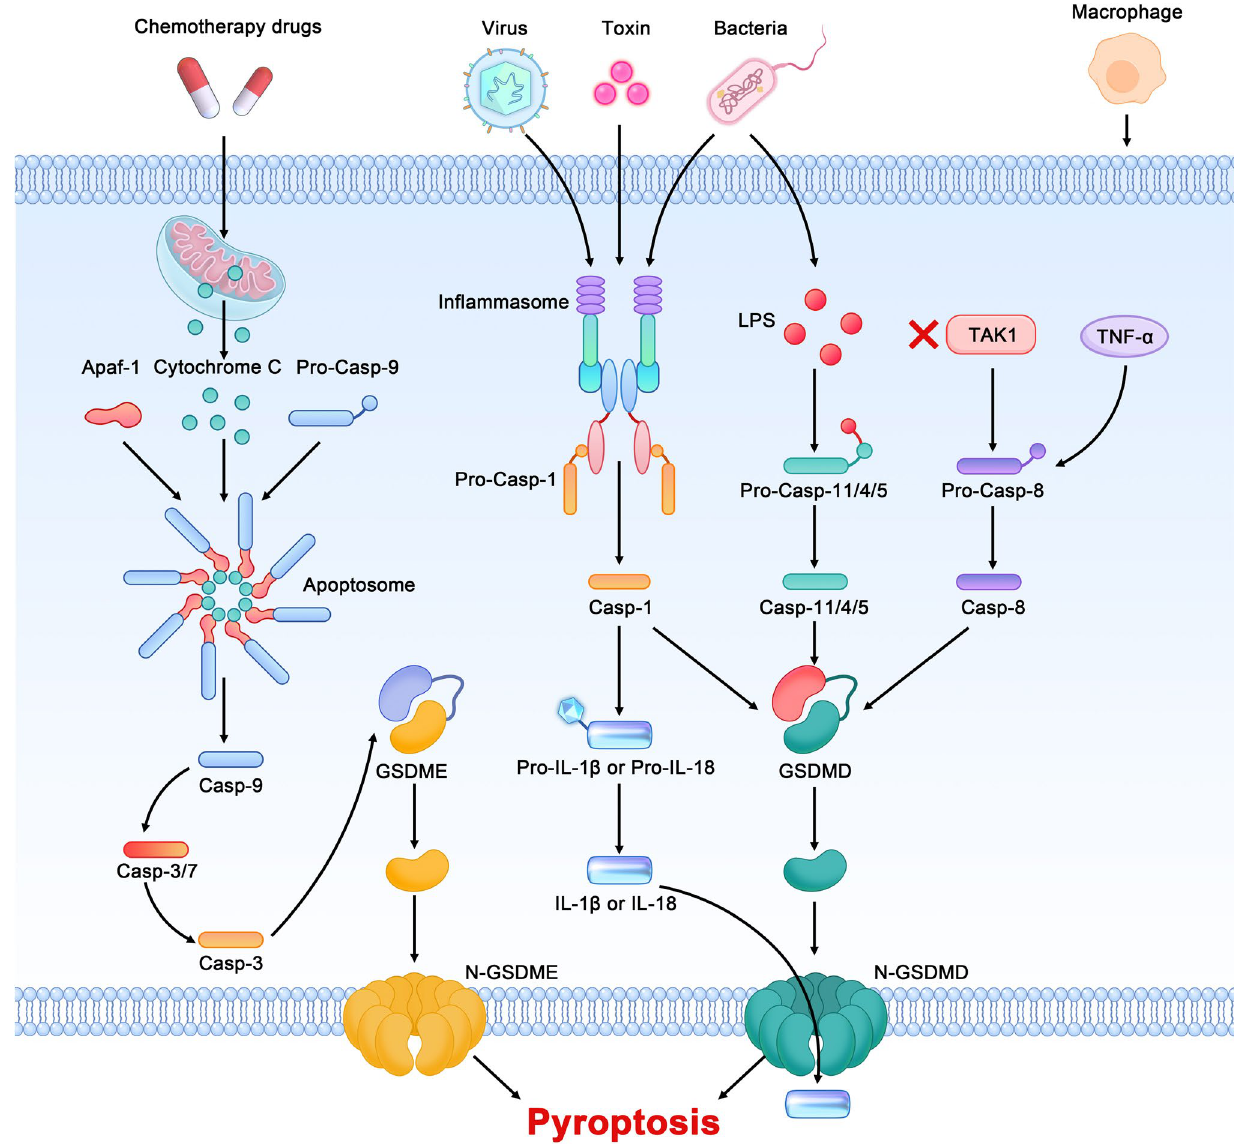
Fig. 1 Molecular mechanisms of the canonical inflammasome, noncanonical inflammasome and other caspase-mediated processes in